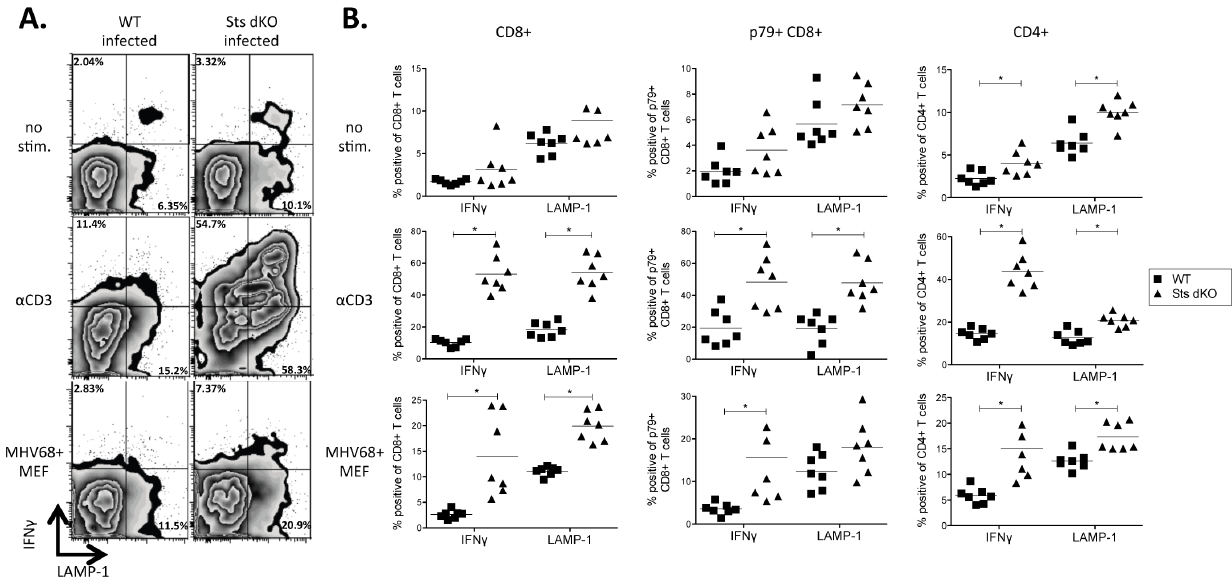
Figure 2. Sts dKO CD4 + and CD8 + T cells have increased effector responses to infected cells. Sts dKO and C57BL/6 WT mice were infected 1000 PFU of MHV68 by the intranasal route and spleens were harvested 28 dpi. Stimulations were performed as described in Figure 1 with the addition of a LAMP1, followed by costaining for CD4, CD8, and p79 tetramers. (A) Representative flow plots of LAMP-1 and IFN c expression on CD8 + T cells are shown for each genotype and culture condition. (B-D) Scatter plot of the percentage of the indicated T cell subsets positive for IFN c or LAMP-1. Axes were adjusted to better illustrate differences within each experimental condition. Symbols represent data from individual mice. *=p , .05, **=p , .01, ***=p , .001. **** =p , .0001.